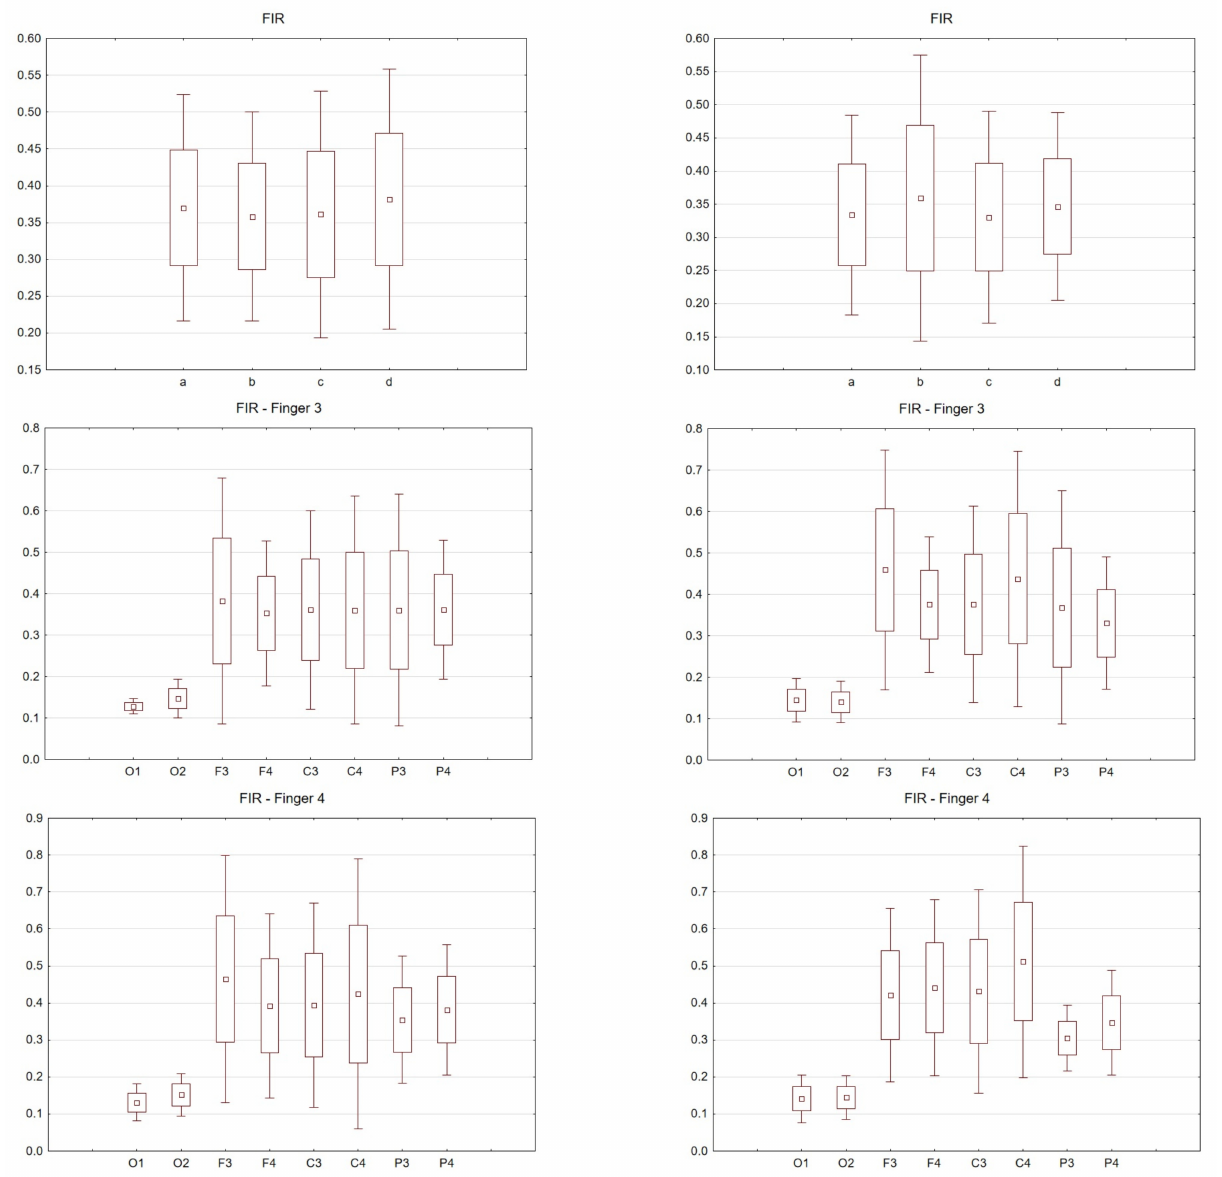
Figure 5. Latency values (s) FIR filter: Top drawing for all and individual fingers: a—all fingers, b—“2” fingers, c—“3” fingers, d—“4” fingers and electrodes P4. Middle drawing for finger 3 and all electrodes. Bottom drawing for finger 4 and all electrodes. Right hand (left in the photo) and left hand (right